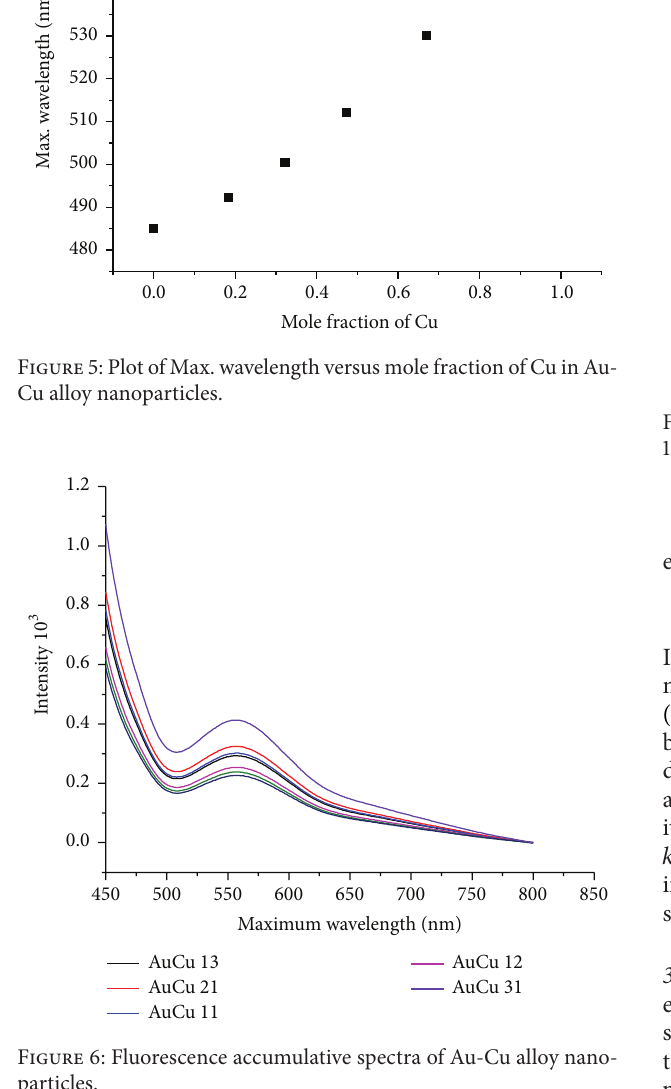
Figure 6: Fluorescence accumulative spectra of Au-Cu alloy nano- particles.